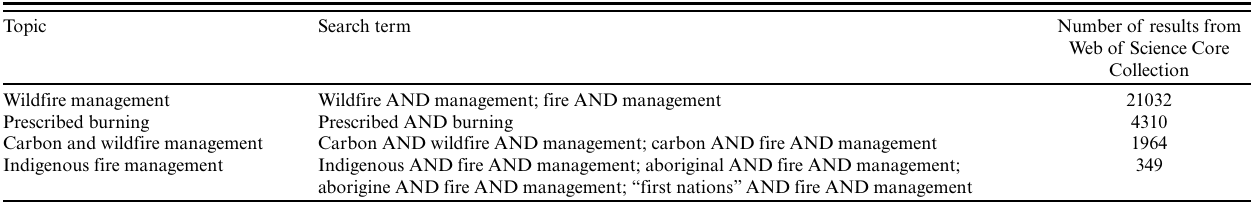
Table 1 . Preliminary search of fire management